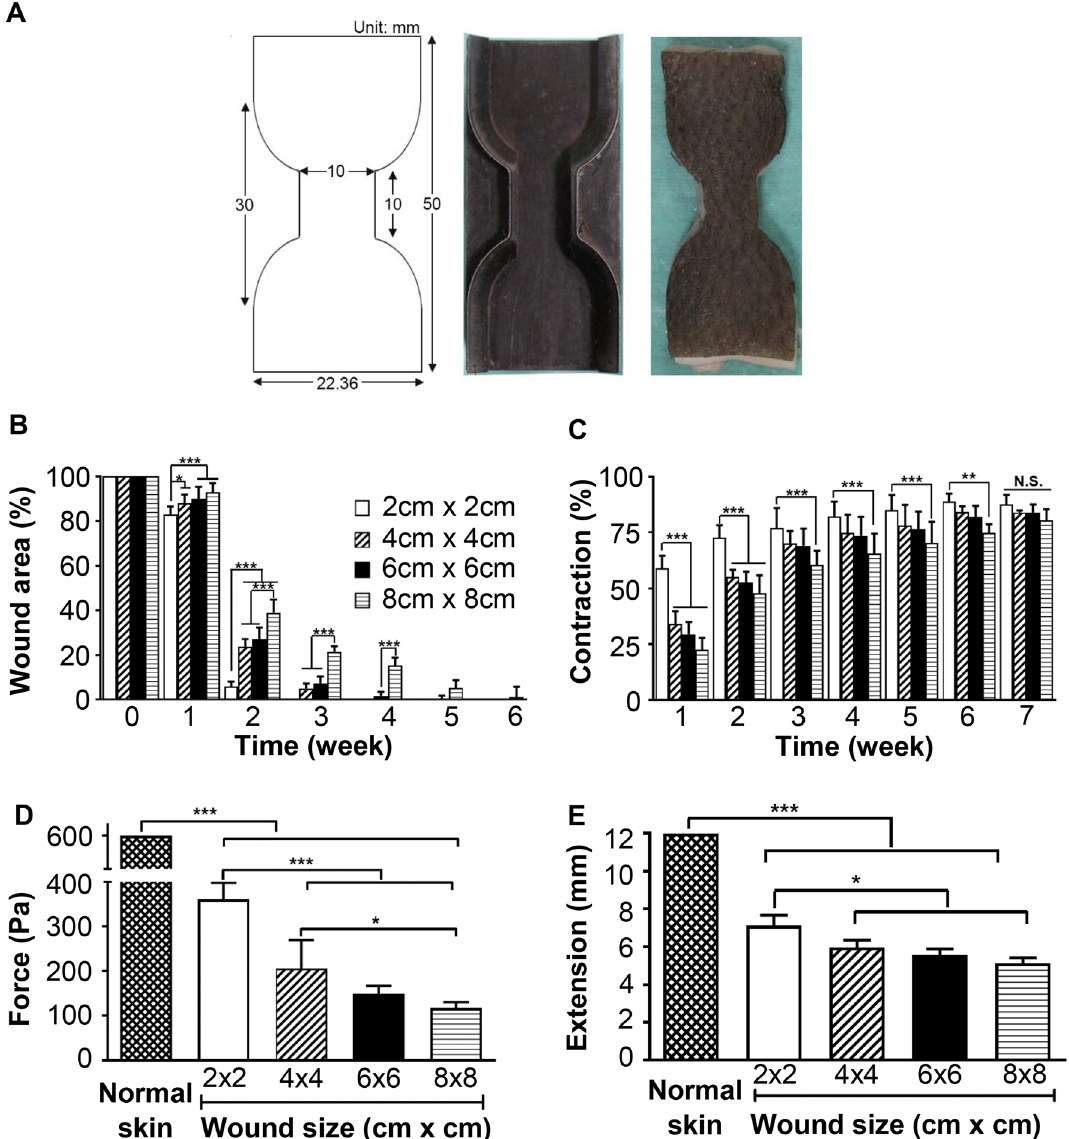
Figure 5. Comparison of various wound sizes for the wound array model in Lanyu pigs. Full-thickness wounds of 2 cm × 2 cm, 4 cm × 4 cm, 6 cm × 6 cm, and 8 cm × 8 cm were created on the dorsal skin of three Lanyu pigs. ( A ) A mould for punching tissues and a punched tissue with a dumbbell shape (10 mm wide in the center). ( B ) Changes in the wound areas with various wound sizes were measured with time. ( C ) Changes in the wound contraction with various wound sizes were measured with time. ( D ) Forces required to lacerate bell-shaped samples of normal skin or regenerated wound tissues were measured using a tensile tester. The samples were collected for measurement at 6 months postoperatively. ( E ) Lengthening of the samples before rupture, as indicated in ( D ) was measured. Statistical significances of each parameter among various wound sizes were analyzed through